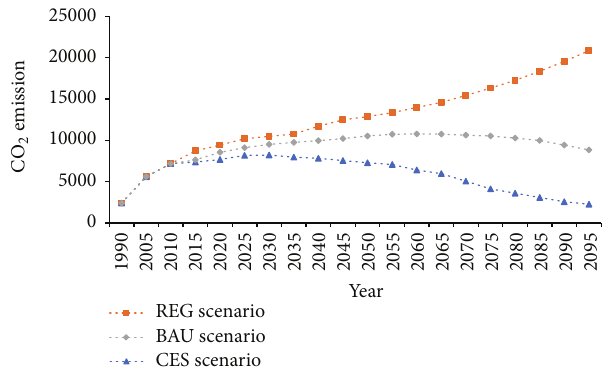
Figure 6: CO 2 emissions under three scenarios during 1990–2095 (unit: